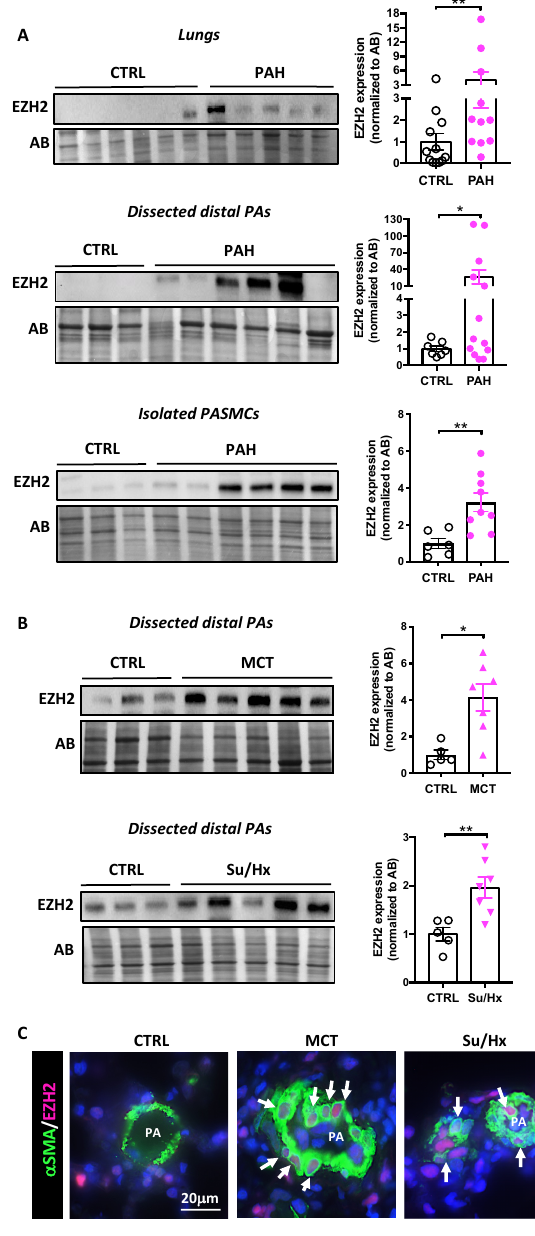
Figure 1. Expression of EZH2 in patients with pulmonary arterial hypertension (PAH) and animal models. ( A ) Representa- tive Western blots and corresponding densitometric analyses of EZH2 expression in lung biopsies, dissected pulmonary arteries (PA), and isolated PA smooth muscle cells (PASMCs) from control ( n = 6–12) and PAH ( n = 9–13) patients; ( B ) Representative Western blots and corresponding densitometric analyses of EZH2 expression in PAs dissected from control rats as well as monocrotaline (MCT)- and Sugen/hypoxia (Su/Hx)-induced pulmonary hypertension rat models ( n = 5–7 rats per group); ( C ) Double immunofluorescence staining for α SMA (green) and EZH2 (red) and DAPI nuclear staining showing nuclear expression of EZH2 in remodeled distal PAs after MCT injury or Sugen/hypoxia exposure compared to nontreated rats. Graphs on the right represent the quantification of the medial wall thickness of distal PAs and the percentage of PASMCs positive for EZH2 in distal pulmonary vessels ( n = 3 per group, mean of 15 vessels/rat). Arrows mark positive cells. Scale bar = 20 µ m. Protein expression was normalized to Amido black (AB). Data are presented as mean ± SEM; * p < 0.05; ** p < 0.01; and *** p <